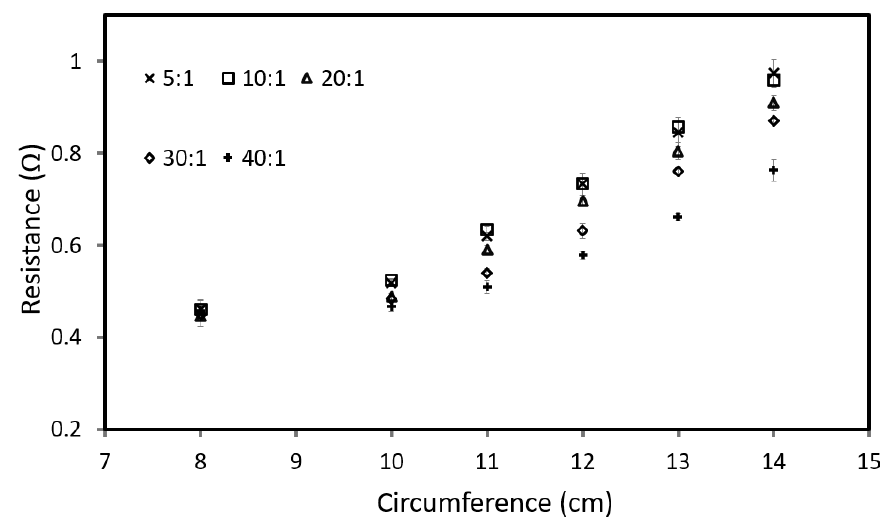
Figure 8. Comparison of resistance value for R-sensors with different mixing ratios.